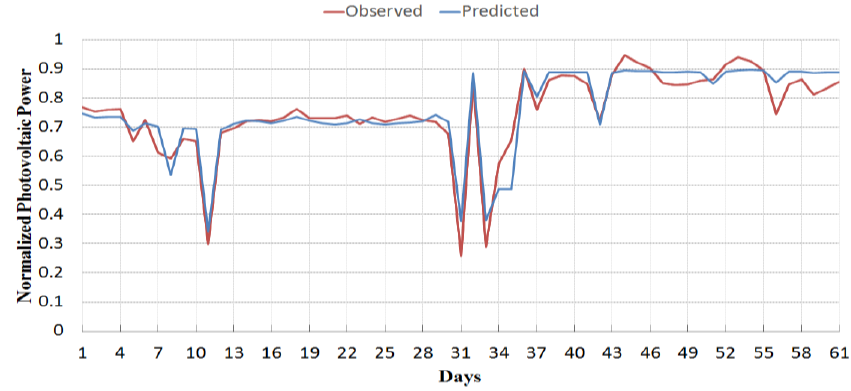
Figure 9. The predicted photovoltaic power values of the WOA-MLP method, which used SR TH , and SR DH inputs.